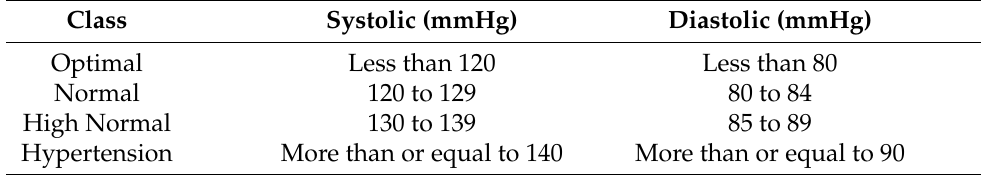
Table 1. Categorization of blood